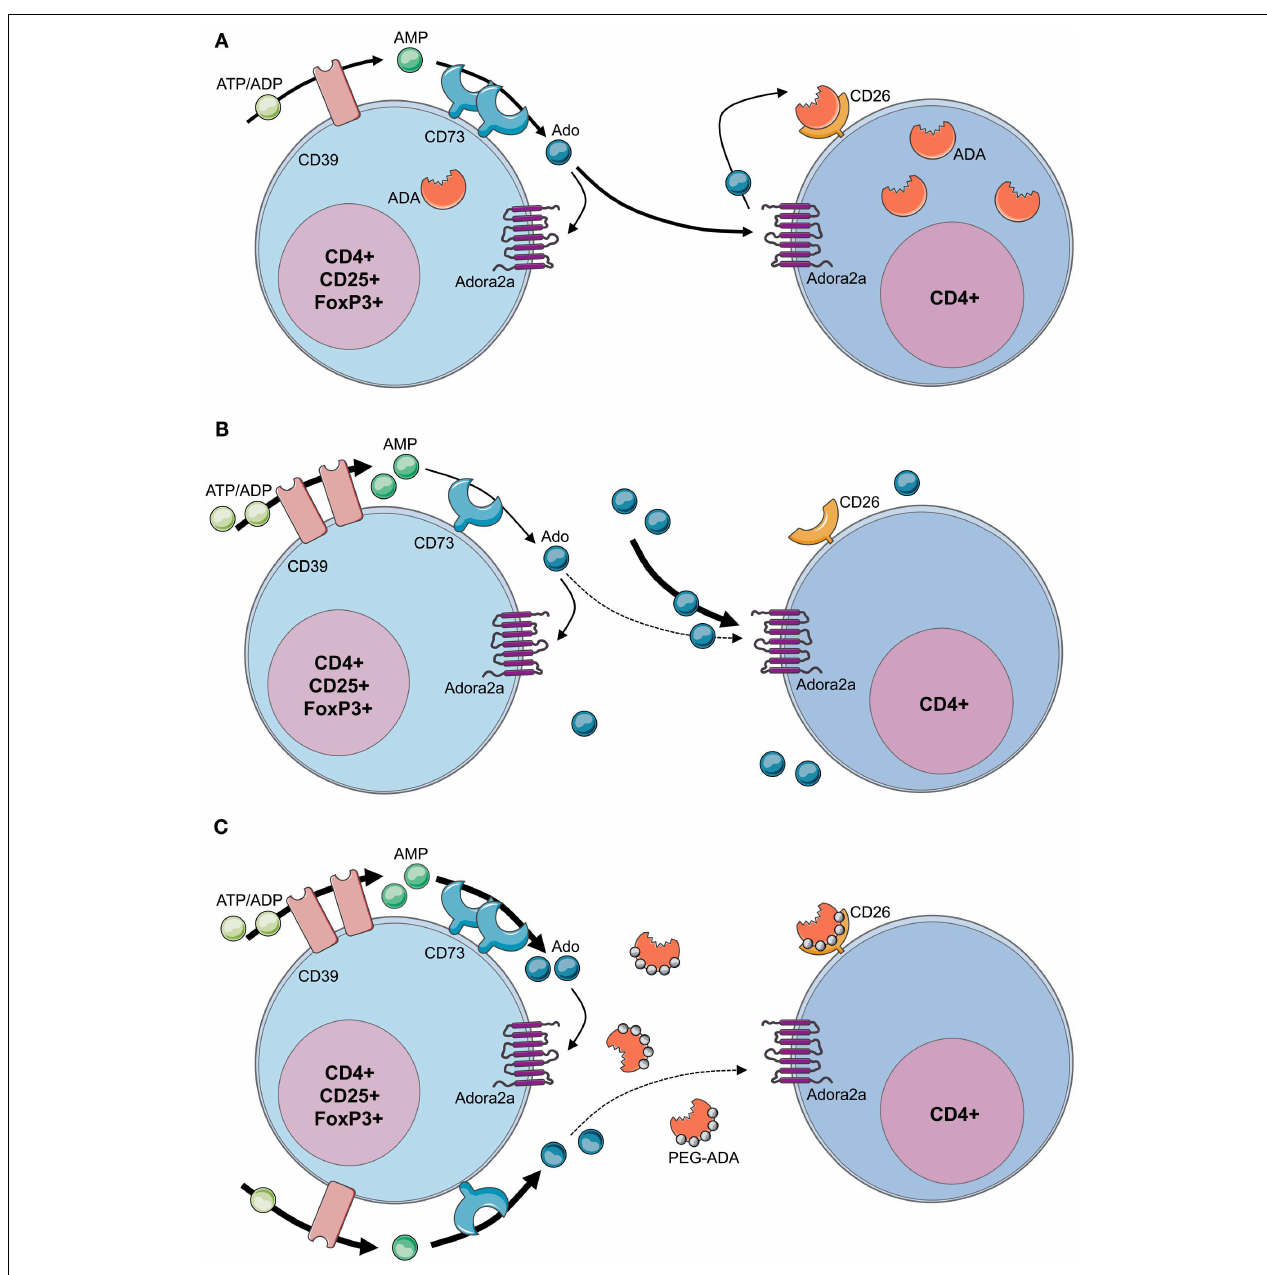
levels, possibly to avoid a further increase of extracellular concentrations, CD73 is reduced and ADA − / − Tregs display a decreased suppressive activity towardT effector cells. Nevertheless no apparent autoimmune manifestations can be observed at onset, likely due to the severely reduced effectorT- and B-cell populations. Moreover, the accumulating extracellular adenosine is likely to maintain an anti-inflammatory environment in these mice. (C) After PEG-ADA treatment, the adenosinergic machinery of CD39 and CD73 are upregulated, indicating an increased requirement for ATP hydrolysis and enhanced adenosine production. Despite the initial rescue of suppressive activity by upregulation of CD73 for elevated adenosine production, long-term PEG-ADA treatment interferes withTreg function by augmenting adenosine turnover. PEG-ADA present in the extracellular space eliminates adenosine produced by the ectoenzymatic chain and hinders adenosine-mediated suppression by interfering between adenosine and Adora2a expressed onT effector